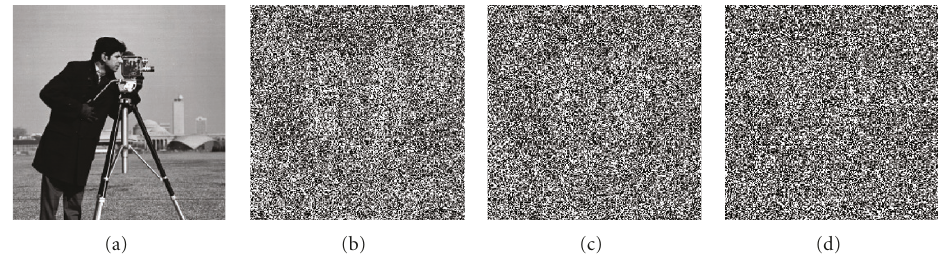
Figure 6: (a) Original Cameraman image. (b) Image corrupted by 70% noise density. (c) Image corrupted by 80% noise density. (d) Image corrupted by 90% noise density.